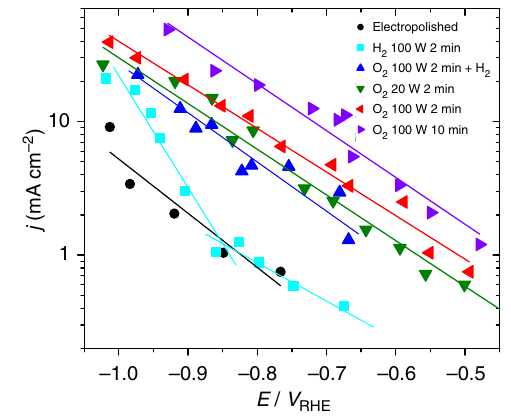
Figure 4 | Electrochemical activity during CO 2 electroreduction. Geometric reduction current density as a function of applied